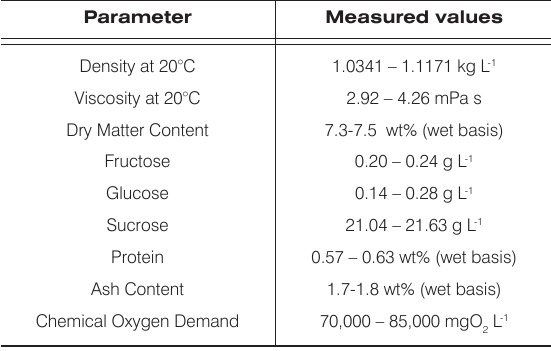
Table 2. Mineral content of soy process water measured on dry basis (analysed by ICP-MS method).